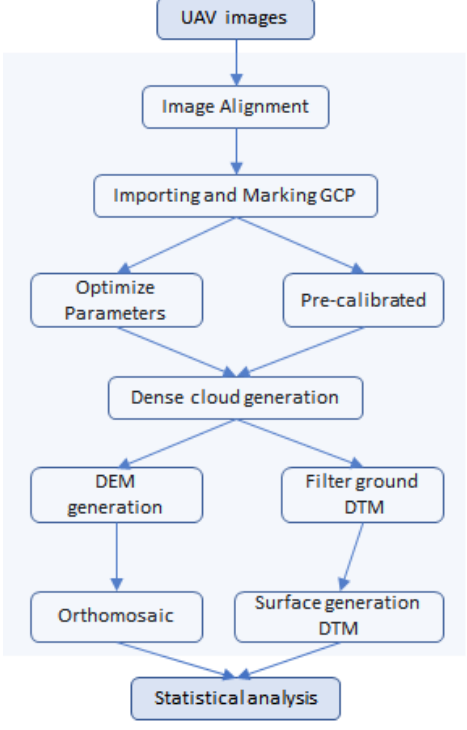
Figure 5. Standard photogrammetric